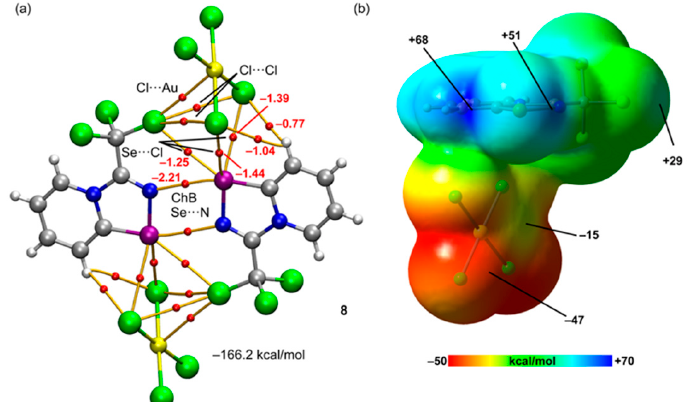
Figure 5. ( a ) QTAIM analysis of compound 8 . Only intermolecular bond CPs and bond paths are represented. The interaction energies of the ChB and HB contacts are indicated next to the bond CPs (small red spheres) in kcal/mol. ( b ) MEP surface of 8 using the 0.001 a.u. isodensity value. The MEP at selected points of the surface are indicated in kcal/mol.